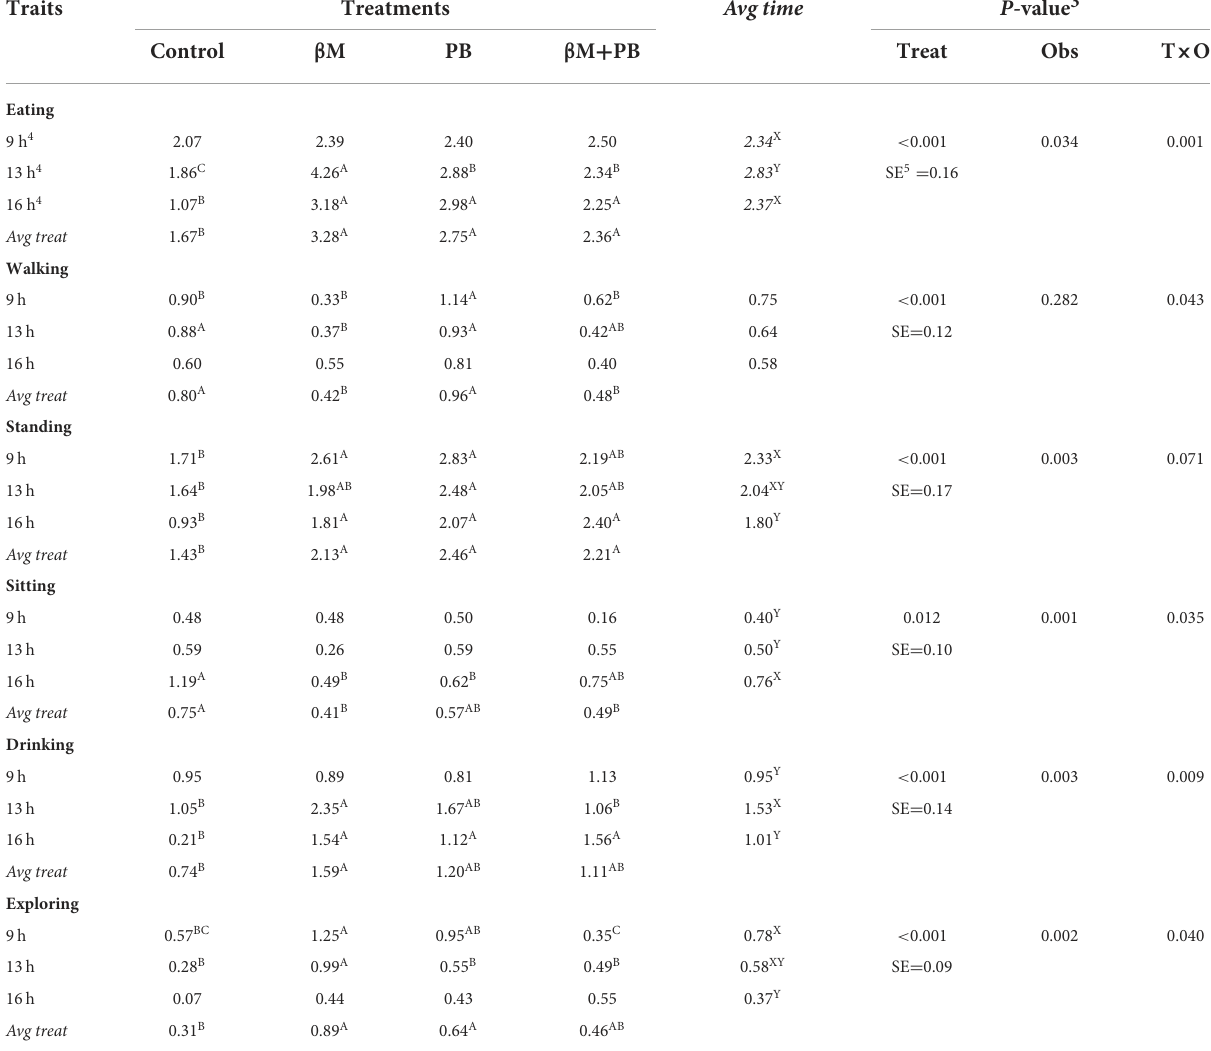
TABLE 2 Frequency of the main behaviours 1 observed in laying hens fed β -mannanase ( β M) and/or probiotics (PB) 2 .